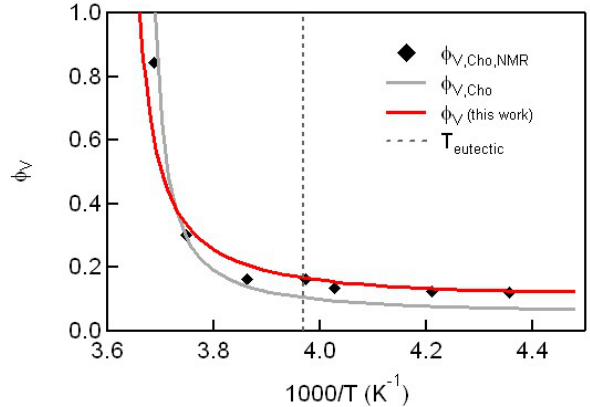
Fig. 2. Volume fraction of brine layer on frozen sea water extracted 510 from NMR data by Cho et al. (2002) as a function of temperature. The solid gray line represents the calculated volume fraction of the brine layer using Cho’s model. The solid red line represents the calculated thickness of the brine layer using the BL model in this study. The eutectic temperature is marked by the dotted vertical line.